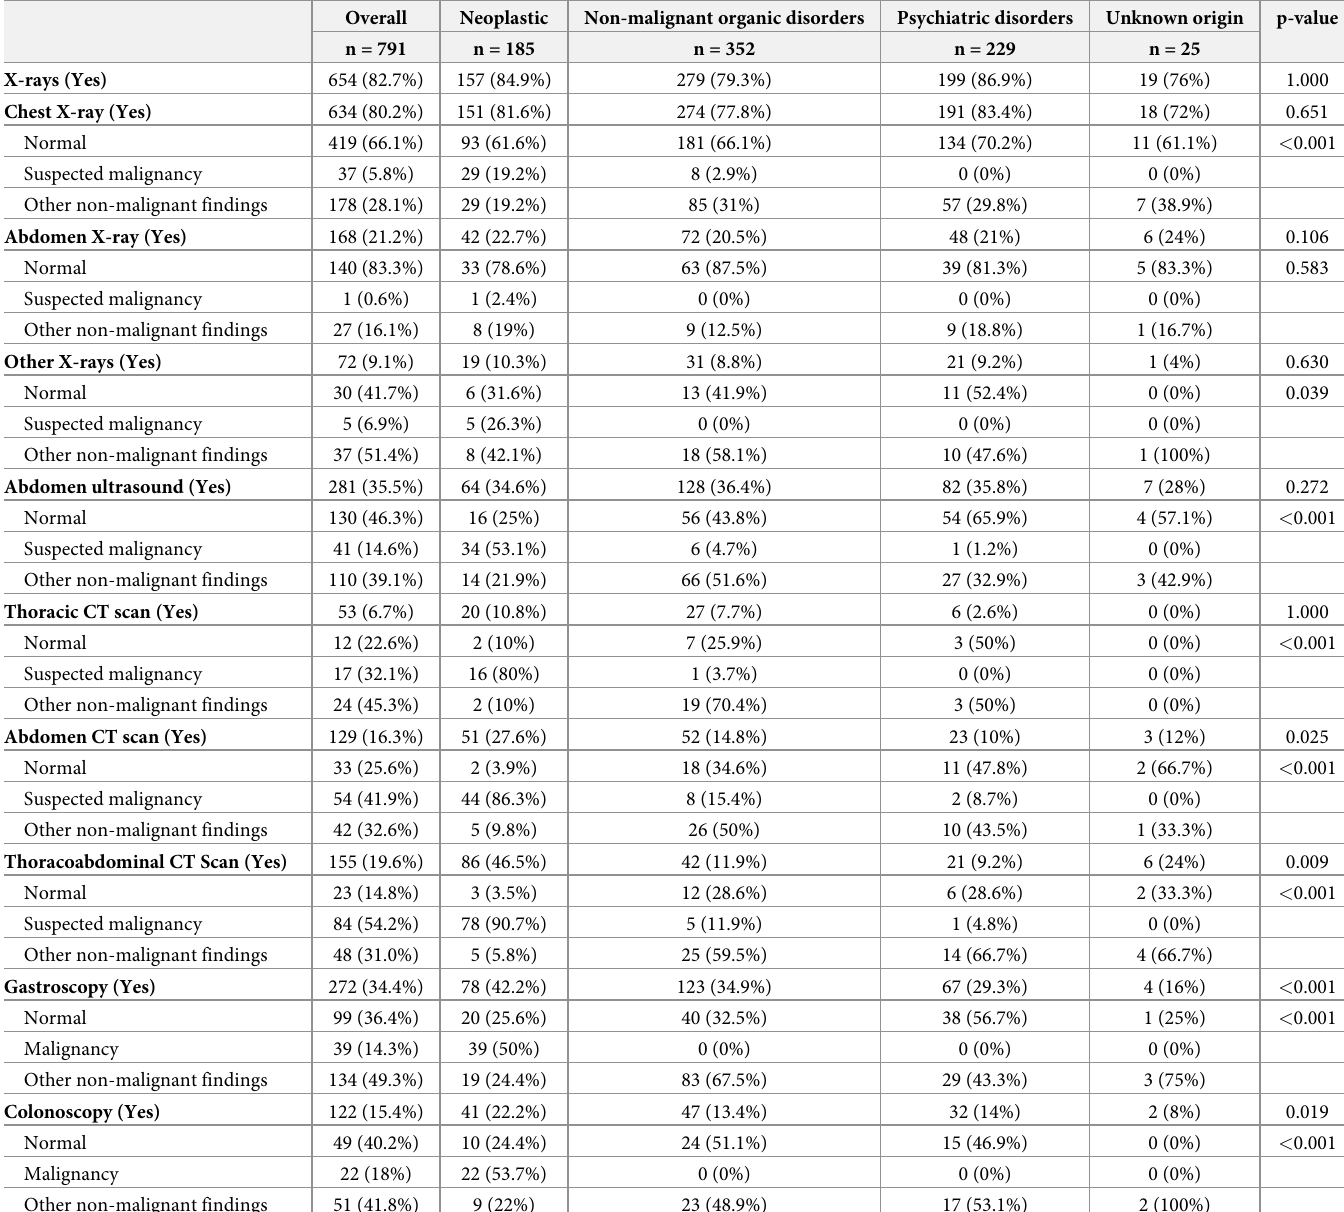
Table 3. Diagnostic imaging of patients with IWL, overall and according to